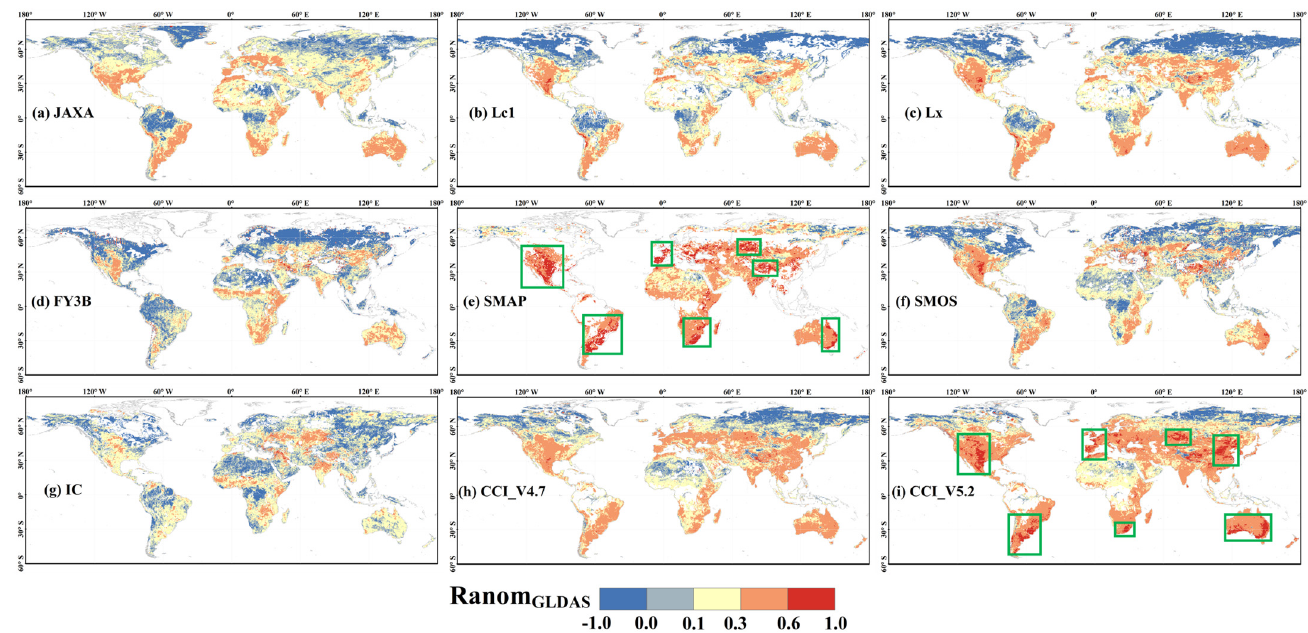
Figure 8. Spatial distribution of Ranom against GLDAS for ( a ) JAXA, ( b ) Lc1, ( c ) Lx, ( d ) FY3B, ( e ) SMAP, ( f ) SMOS, ( g ) IC, ( h ) CCI_V4.7, and ( i ) CCI_V5.2. The regions with Ranom > 0.6 of SMAP and CCI_V5.2 are outlined with green boxes.